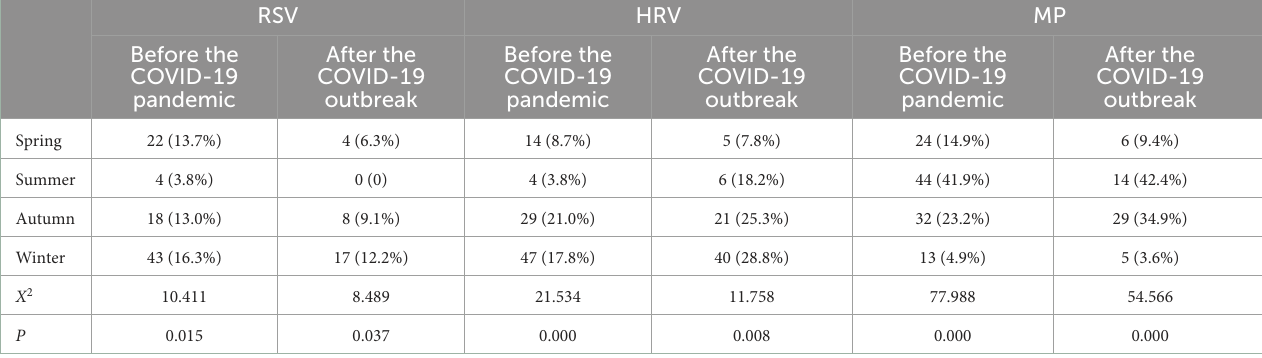
TABLE 3 Age distribution of common respiratory pathogens in children with bronchial asthma before and after the COVID-19 outbreak. RSV HRV MP Before the After the Before the After the Before the COVID-19 COVID-19 COVID-19 COVID-19 COVID-19 pandemic outbreak pandemic outbreak pandemic